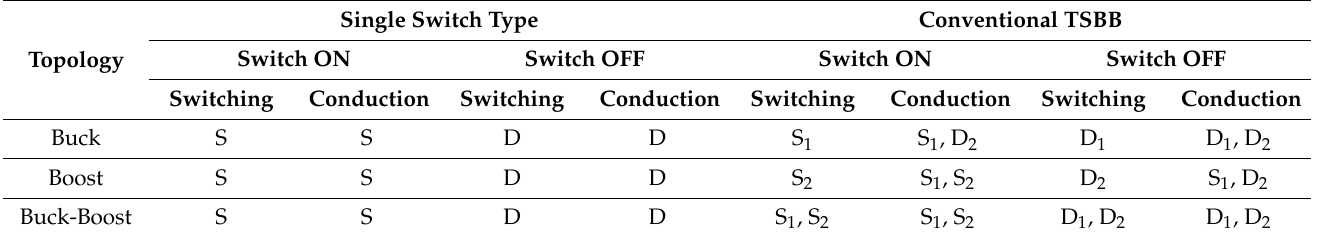
Table 2. Switch operation of the conventional TSBB converter. Component Topology Period S 1 S 2 D 1 D 2 Switch ON ON OFF Always OFF Always ON Buck Switch OFF OFF ON Switch ON ON OFF Always ON Always OFF Boost Switch OFF OFF ON Switch ON ON ON OFF OFF Buck-Boost Switch OFF OFF OFF ON ON Table 3. Switching and conduction semiconductors of single switch converters and the conventional TSBB